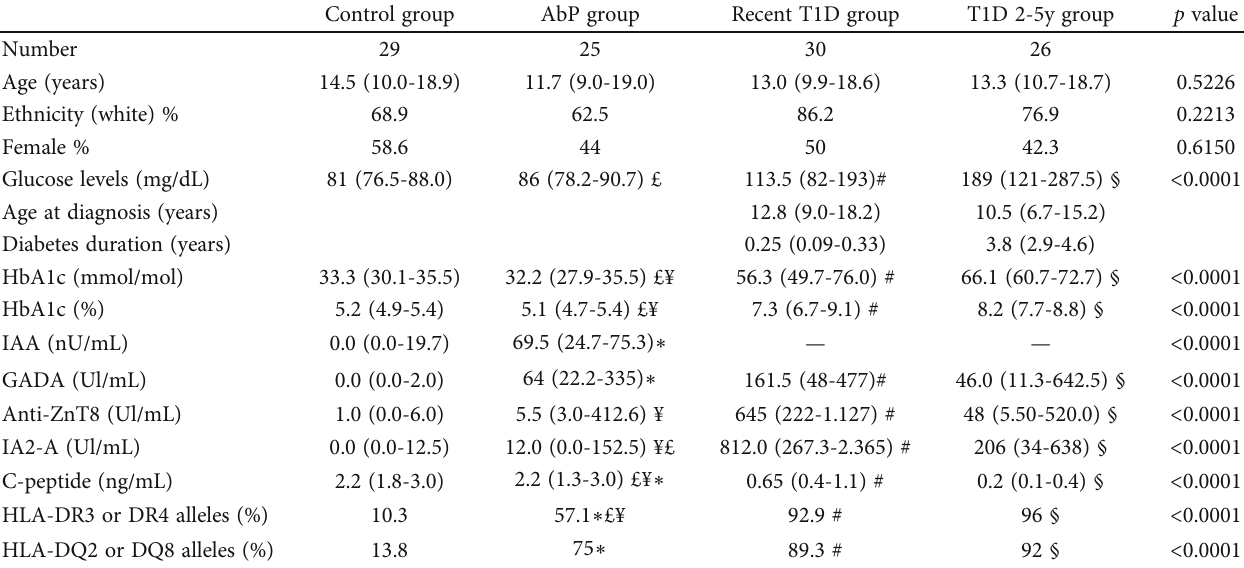
Table 1: Expression of serum miRNAs of AbP, recent T1D, and T1D 2-5y groups in relation to the control